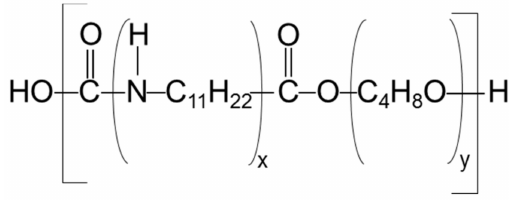
Figure 1. Chemical structure of Pebax ®